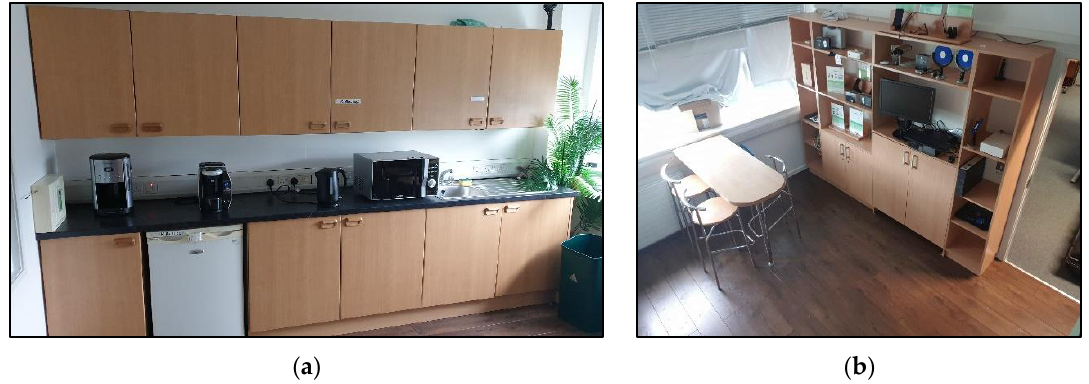
Figure 2. ( a ) Photograph capturing the kitchen bench, fridge and overhead cupboards within the smart environment and ( b ) photograph depicting the kitchen table and chairs in the smart environment.